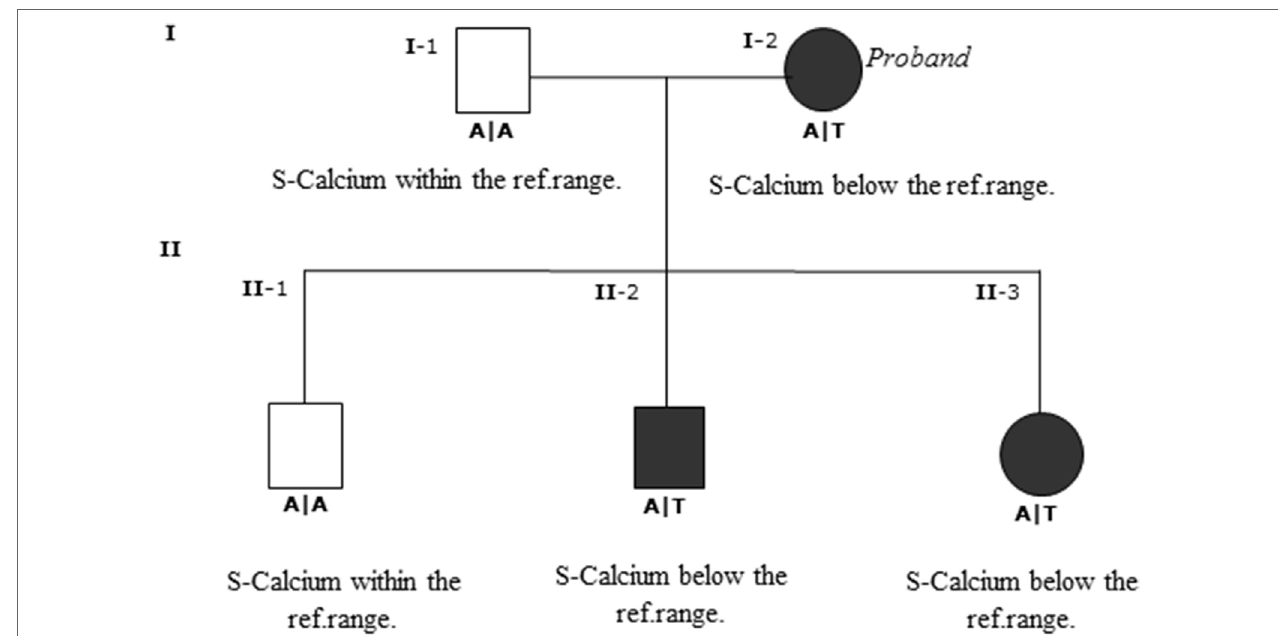
FigUre 2 | Genotype and pedigree of the family investigated. The nucleotide substitution was identified in I-2 (proband) and in II-2 and II-3 both affected progeny of the proband. The proband and the affected progeny all have S-calcium below reference range, I-2 had severe muscle pain, tetany, and depression; II-2 had gentle muscle pain; and II-3 had diffuse muscle pain and depression. Wild-type homozygous A/A of codon 126 is the open boxes; black boxes are the heterozygous mutant A/T codon.